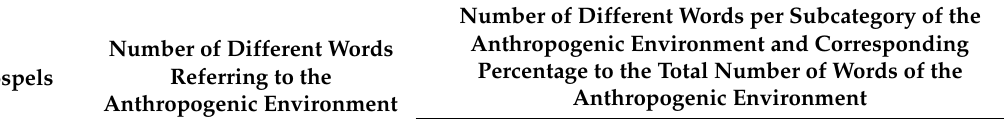
Table 9. Number of unique words referring to the anthropogenic